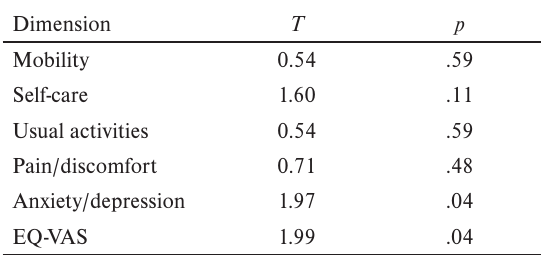
Pre and post-intervention comparison of EQ-5D dimensions Dimension T p